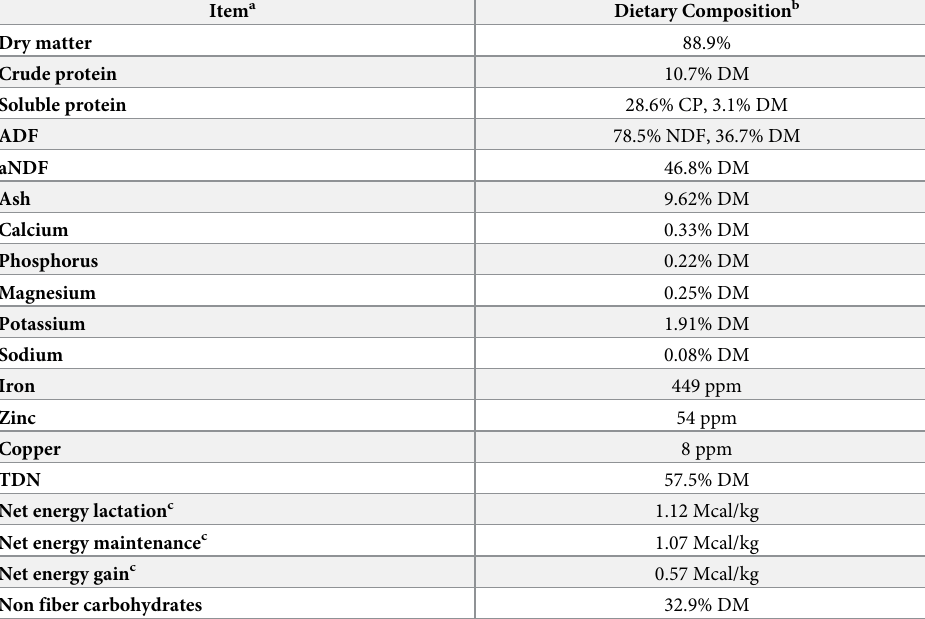
Table 1. Dietary composition of total mixed